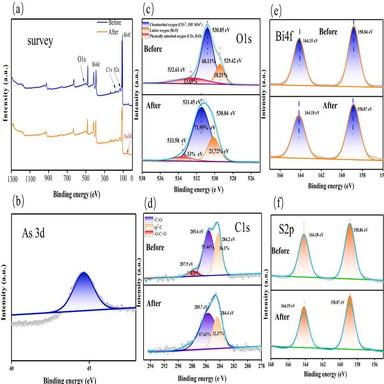
XPS spectra of Bi–O-A before and after adsorption of As (V) (a) survey spectrum, (b) As spectrum, (c) C1s spectrum, (d) O1s before reaction, (e) Bi4f spectrum, (f) S2p spectrum (Test condition: initial arsenic concentration 10 mg/L, dosage 1 g/L, stirring speed 400 rpm, T = 25 ± 1 ◦C).